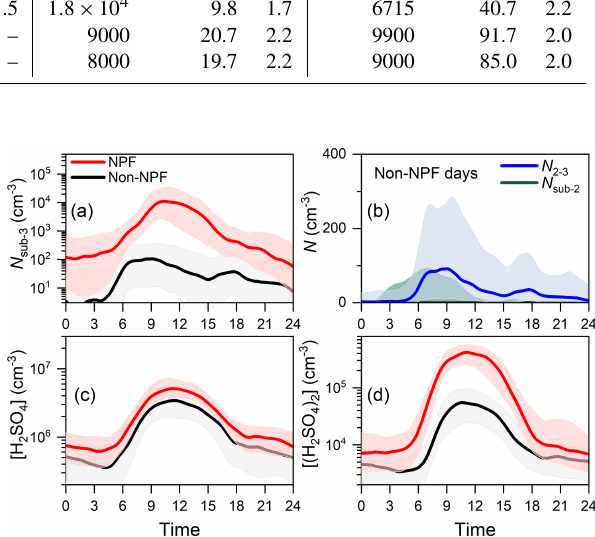
Figure 4. The diurnal variations of (a) number concentration of sub-3nm aerosols ( N sub-3 ), (c) H 2 SO 4 monomer concentration, and (d) H 2 SO 4 dimer concentration on NPF days and non-NPF days. (b) The diurnal variations of number concentration of sub-2nm aerosols ( N sub-2 ) and 2–3nm aerosols ( N 2 − 3 ) on non-NPF days. The solid lines represent median values and the shading areas indi- cate 25th–75th percentiles. Note that the median diurnal variations of N sub-2 are near zero on non-NPF days in (b)